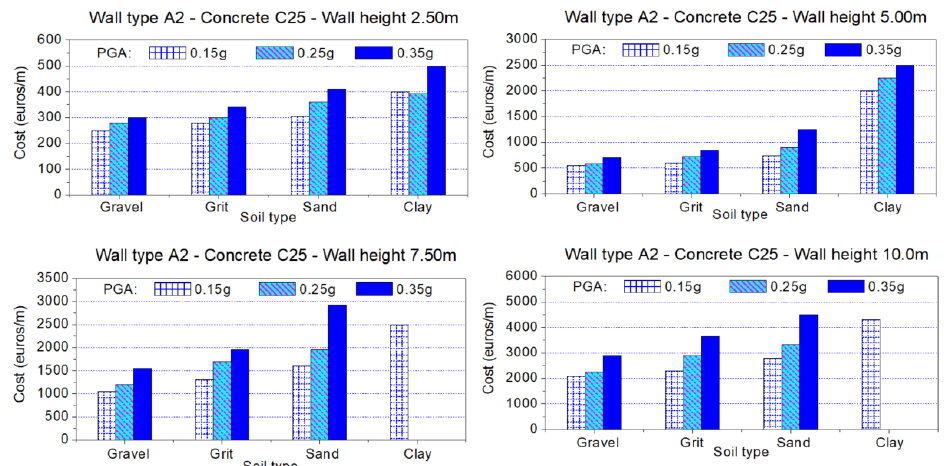
Figure 6. Cost of retaining walls type A2 made by reinforced concrete C25.